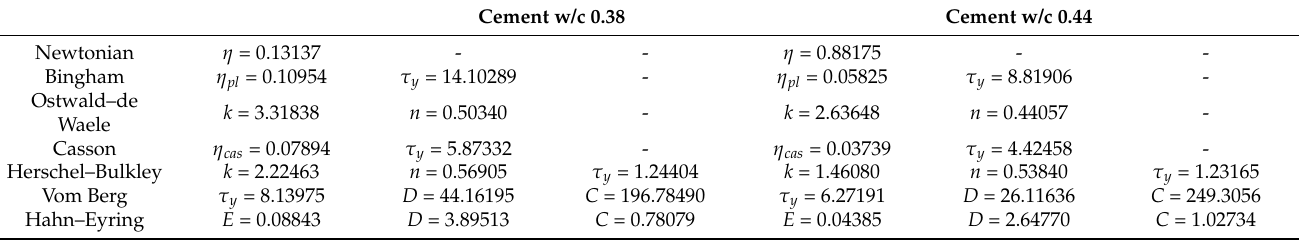
Table 3. Fluid rheological parameters obtained from Rheosolution for cement slurry reference